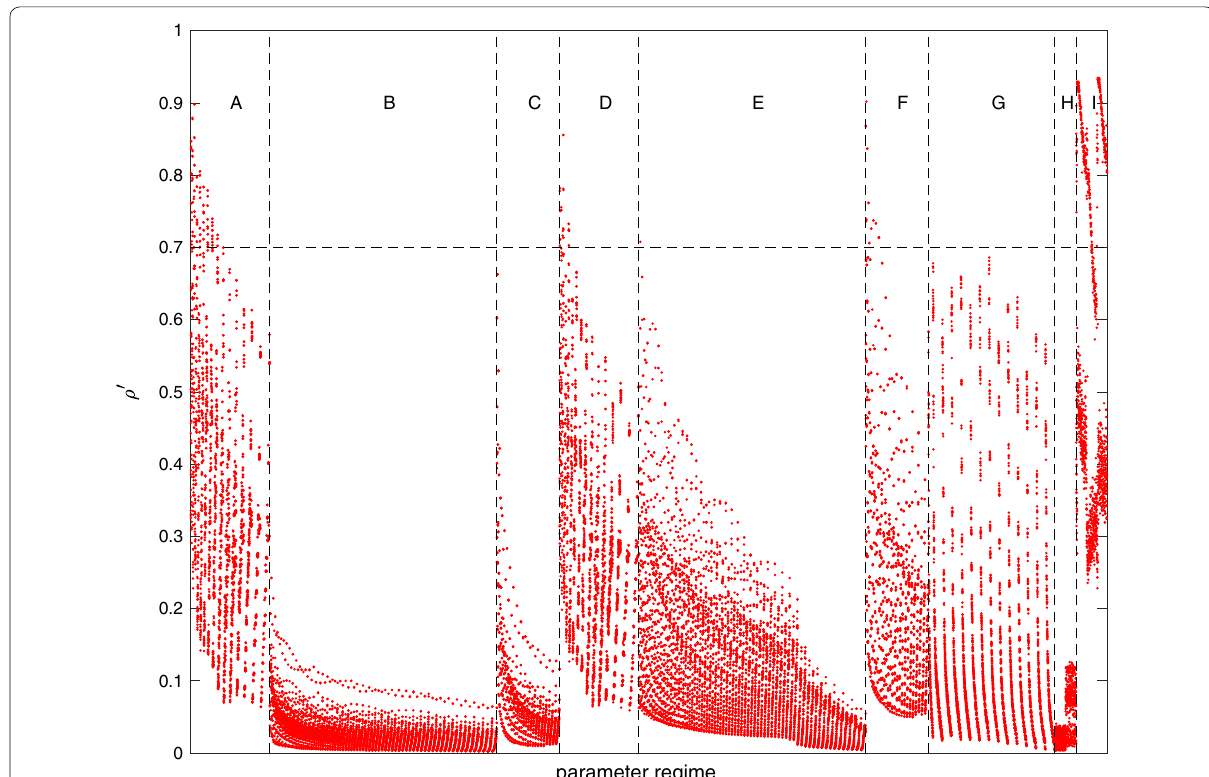
Fig. 3 The ρ ′ value for each non‑magnetospheric/induced parameter. The horizontal dashed line at 0.7 represents the geometric “half‑way point” between uncorrelated and perfectly correlated. The vertical dashed lines delineate between different parameter regimes: (A) nominal core/SV, (B) nominal crust, (C) nominal M 2 tide, (D) nuisance core/SV, (E) nuisance crust, (F) nuisance M 2 tide, (G) ionosphere, (H) OHM biases, and (I) Swarm alignment Euler